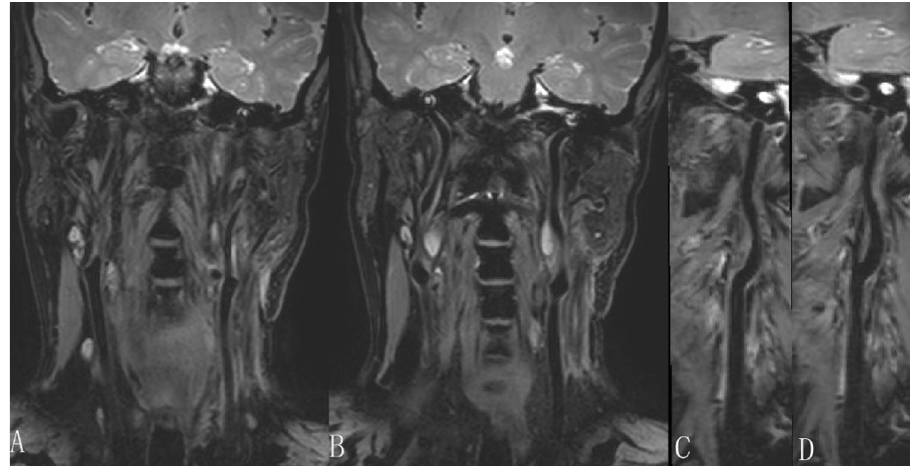
Figure 4. The carotid artery wall in the neck area were well displayed on 3D T2-weighted fast field echo. ( A , B ) coronal view, and ( C , D ) sagittal view.